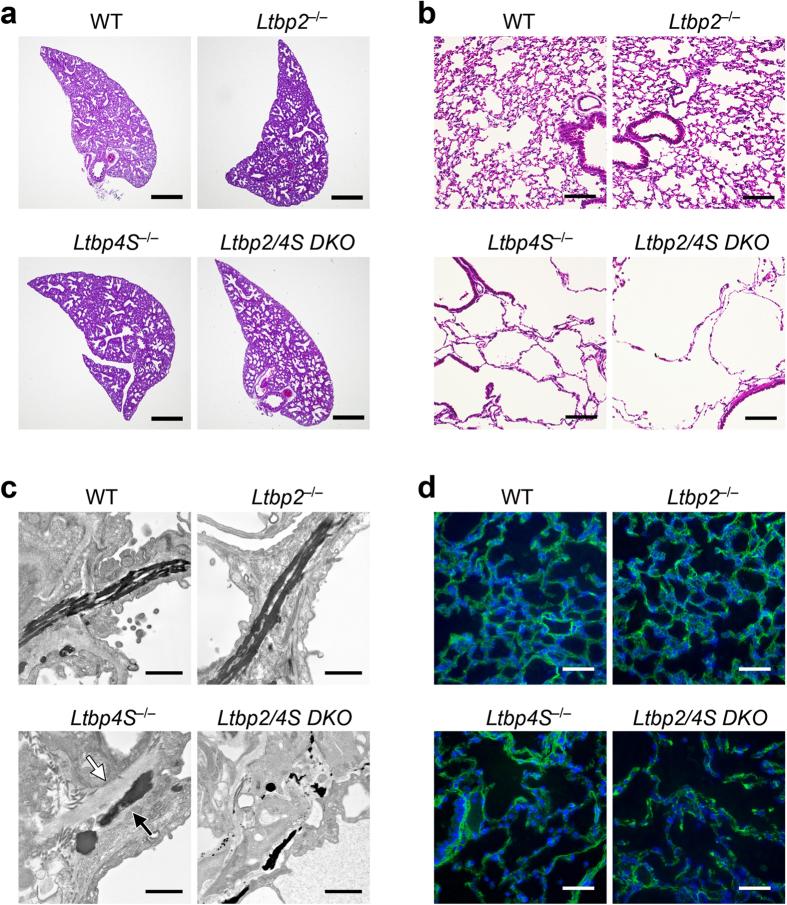
Histological analysis of Ltbp2/4S mutant mouse lungs.(a) Lung sections of mice at embryonic day 18.5 (E18.5) were stained with hematoxylin and eosin. Bars: 400 μm. (b) Lung sections of 8-week-old mice were stained with hematoxylin and eosin. Bars: 100 μm. The terminal air sac enlargement in the lungs of Ltbp2/4S DKO mice was more severe than that observed in the lungs of Ltbp4S−/− mice. (c) Electron micrographs of elastic fibers stained black by tannic acid in the lungs of 8-week-old mice. The elastic fibers of Ltbp4S−/− and Ltbp2/4S DKO lungs were disorganized. Note bare microfibril bundles (open arrow) and elastin deposits outside microfibrils (closed arrow) in Ltbp4S−/− lung tissues. In Ltbp2/4S DKO lung tissues, bare microfibril bundles were not observed, and elastic fibers were more severely fragmented. Bars: 1 μm. (d) Distribution of microfibrils in the lungs of 8-week-old mice. Cryosections of mouse lungs were stained with a rabbit anti-fibrillin-1 antibody and visualized using an Alexa-488-labeled anti-rabbit IgG antibody. Nuclei were stained with Hoechst 33258. Bars: 50 μm.